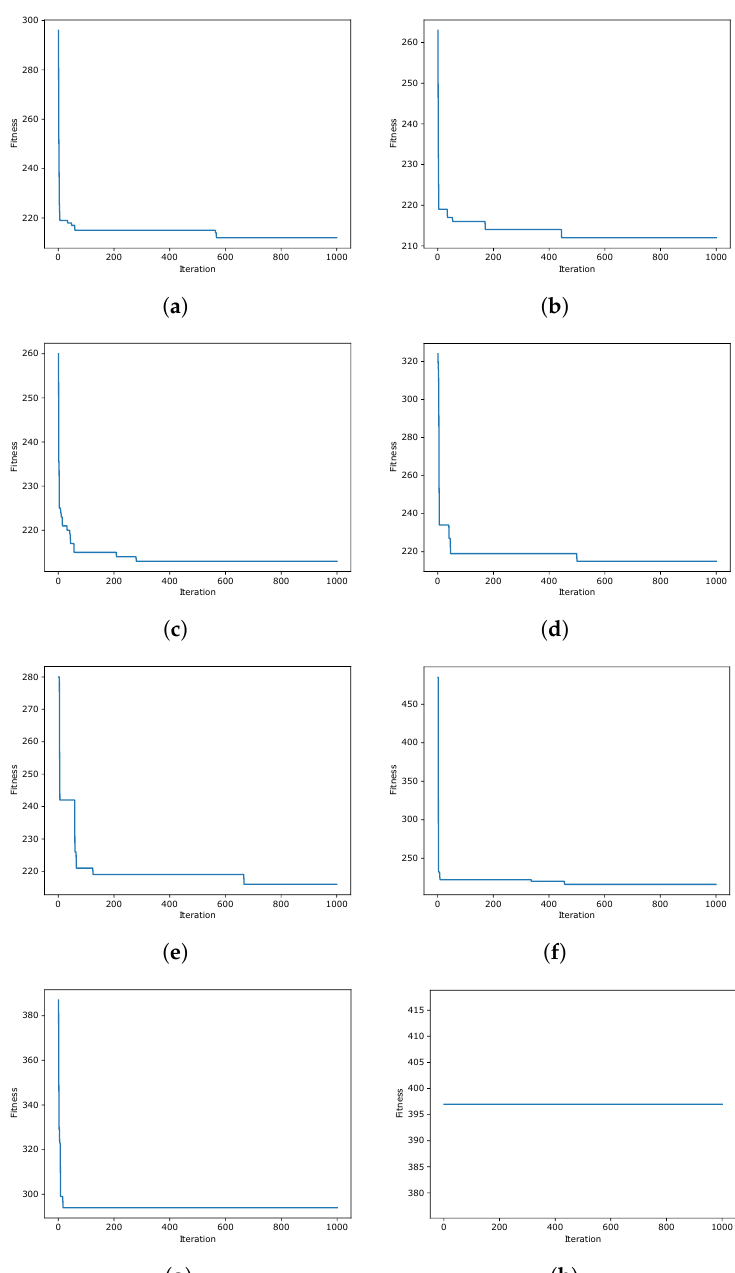
Figure 7. WOA instances coverage when resolving the scp55 instance of the SCP. Instance